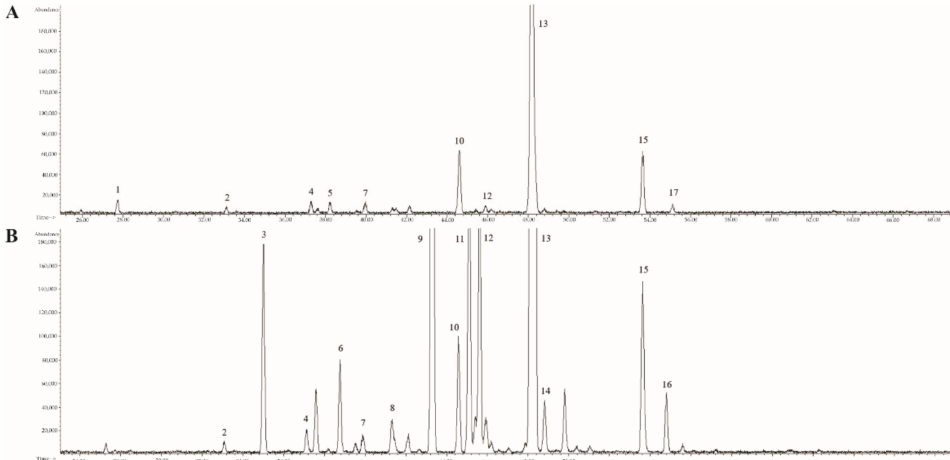
Figure 1. Chromatograms of carbohydrates received by methanolysis of exopolysaccharides isolated from R. leguminosarum bv. trifolii deriving from nodules of white clover growing on a non-polluted reference ( A ) and Zn–Pb waste heap area ( B ). Abbreviations: 1, levoglucosan; 2, β -D-xylopyranose; 3, 6-deoxy-D-glucose; 4, galactofuranoside; 5, α -D-mannopyranose; 6, D-fructose; 7, β -D-galactopyranoside; 8, α -glucofuranose; 9, D-galactose; 10, α -D-glucopyranoside; 11, α